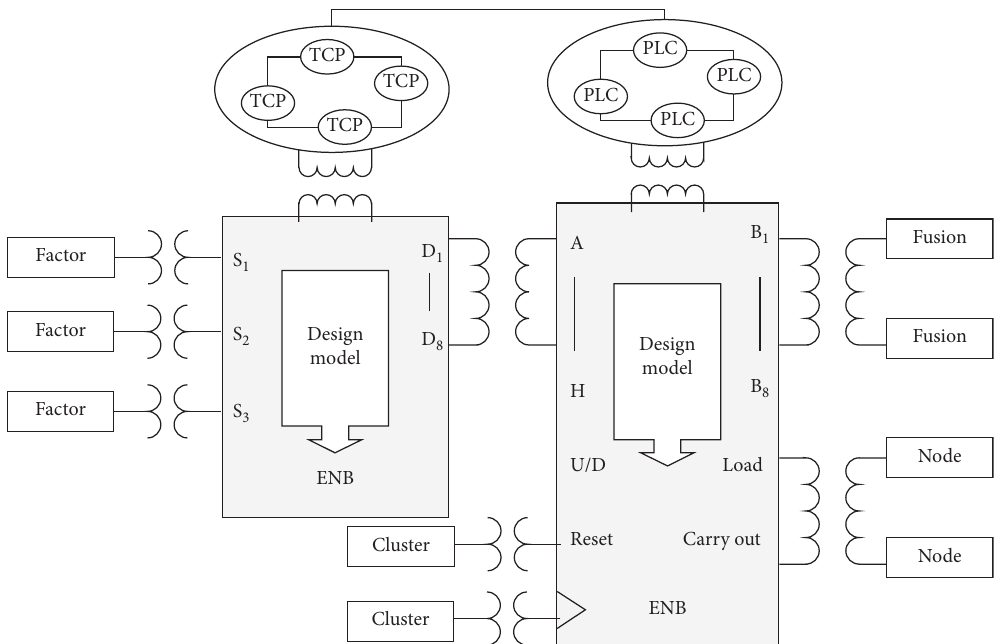
Figure 4: Design model factor fusion framework.